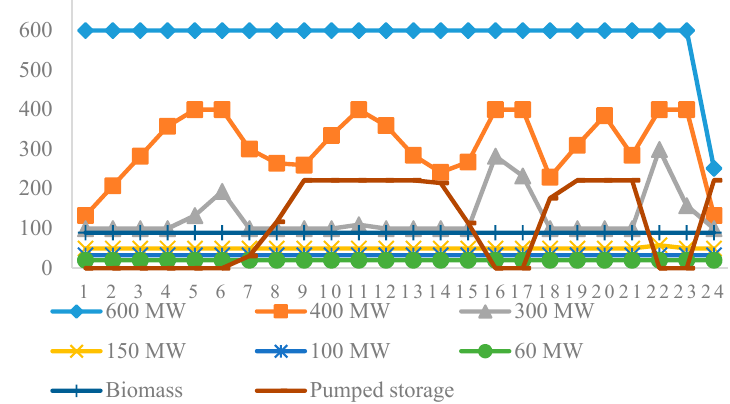
Figure 5. Power curves of different units.